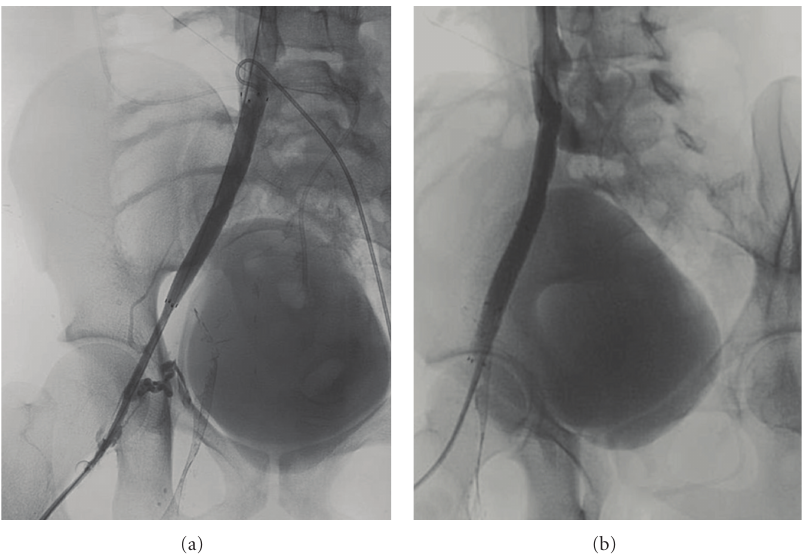
Figure 5: Follow-up venogram showing narrowed external iliac vein and collateral flow to internal iliac collateral (a); completion venogram (b) showing absence of flow in collateral veins as patent right iliac